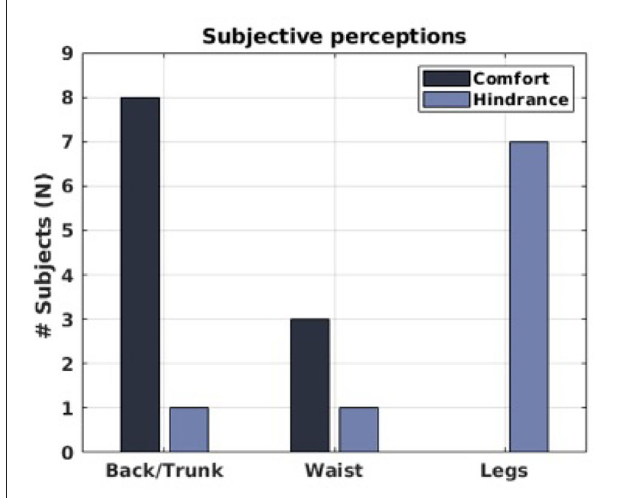
FIGURE 8 | Subjective perceptions of the 9 users. For each of the considered body regions, it is reported how many users felt a benefit and how many experienced